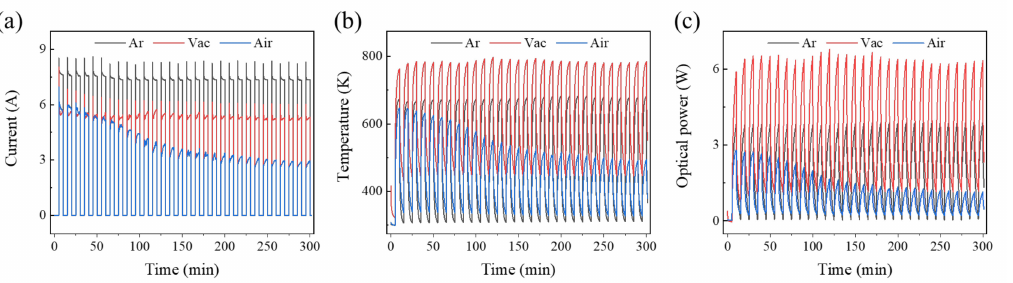
Figure 10. The environmentally controlled high- and low-temperature test outcomes of the silicon- based heating plate used in an integrated LMM emitter in different gas environments. ( a – c ) The dynamic responses of the current, temperature, and optical